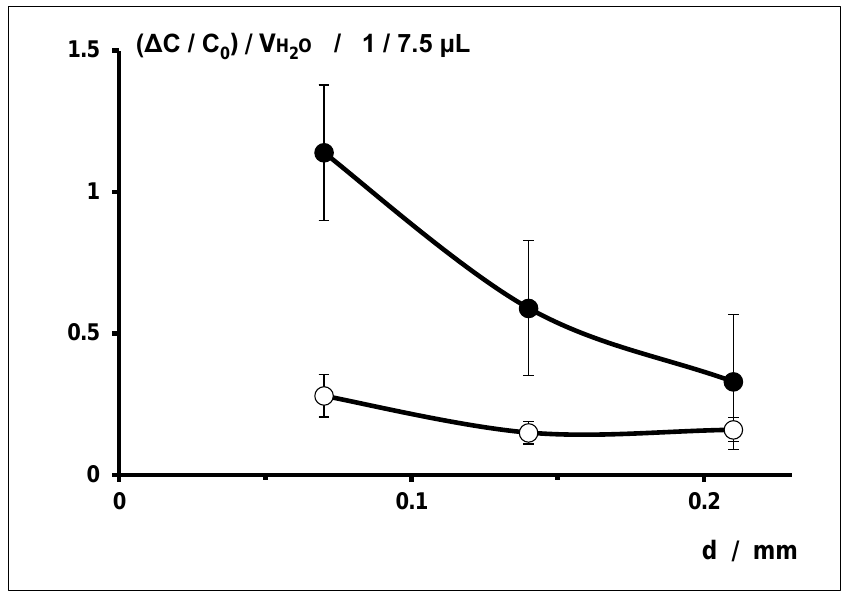
Figure 4. Relative water-specific change in electrical capacitance (ratio of the relative change in electrical capacitance to the causal change in water volume) ( ∆ C/C 0 )/V H series D as a function of the sensor wire diameter d. Sensor wire spacing a = 1 mm; Stitching spacing; b = 1 mm—black, b = 3